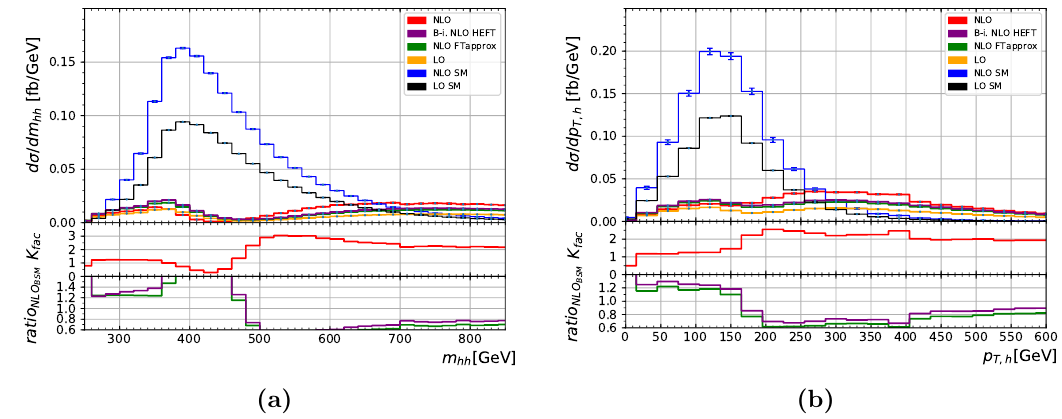
Figure 13. Same as (cid:12)gure 12 but for benchmark point 2, c hhh = 1 ; c t = 1 ; c tt = 0 : 5 ; c ggh = (cid:0) 8 = 15 ; c gghh = (cid:0) 0 :